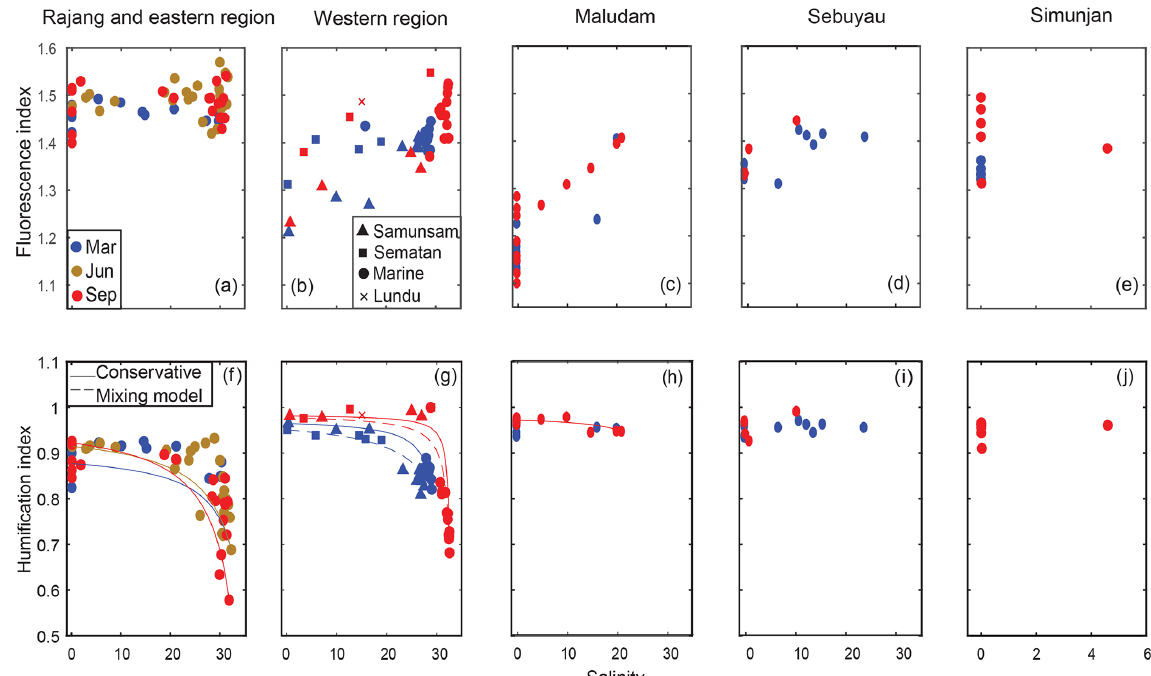
Figure 2. Spatial distribution of the fluorescence index (FI; a–e) and the humification index (HIX; h–l) . Samples from different seasons are distinguished by colors. Samples from different regions are shown in the individual panels, and specified by the titles of each panel. The conservative mixing models of HIX are delineated for the Rajang and eastern region using solid lines in panel (f) , for the Samunsam River using solid lines and for the Sematan River using dashed lines in panel (g) , and for the Maludam River using the solid line in panel (h)